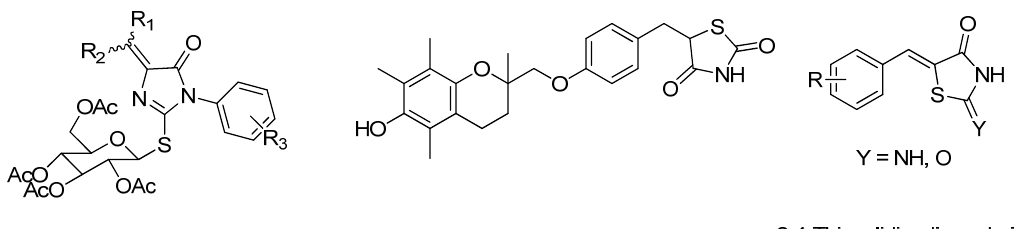
Figure 1. Chemical structure of several biologically important compounds.